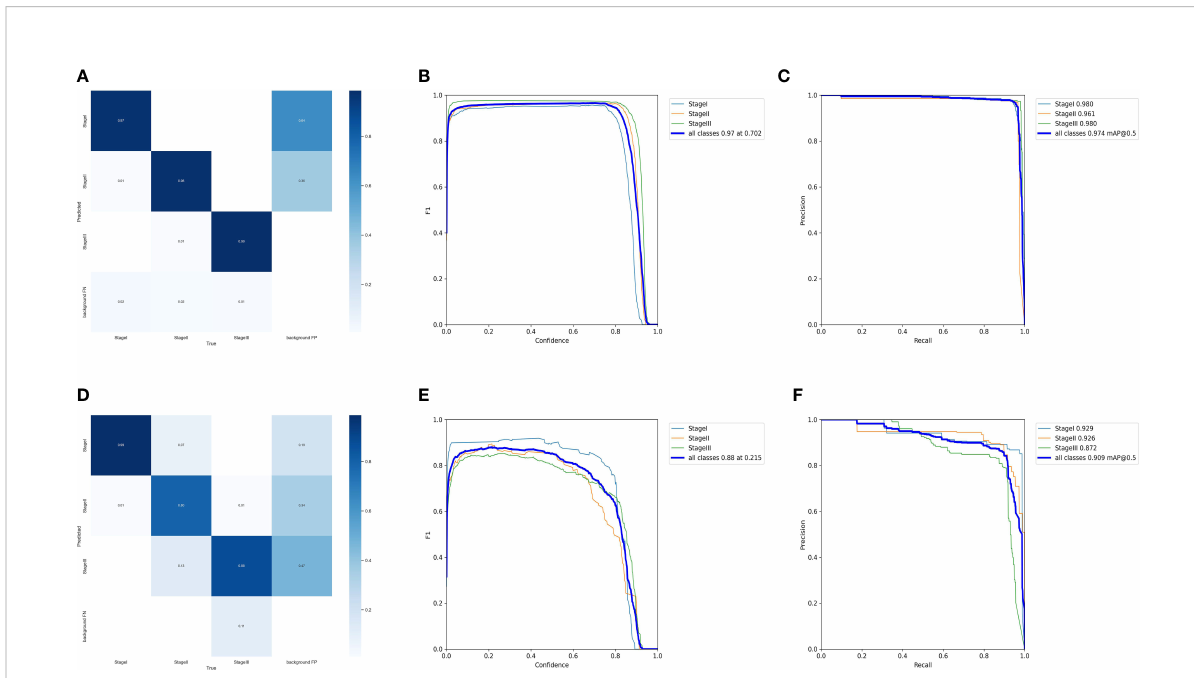
FIGURE 3 Evaluation of DetectionNet performance in the test and external validation cohort. (A, B) The confusion matrix in the test (A) and external validation (B) cohort. (B) The F1 curve. The model had an F1 score of 0.97 in the test cohort. (C, D) The P-R curve. The mAP_0.5 value of the test cohort (C) and external validation cohort (D) were 0.974 and 0.909, respectively. (E, F) The F1 curve. The F1 scores of the model in the test cohort (E) and external validation cohort (F) were 0.97 and 0.88, respectively.